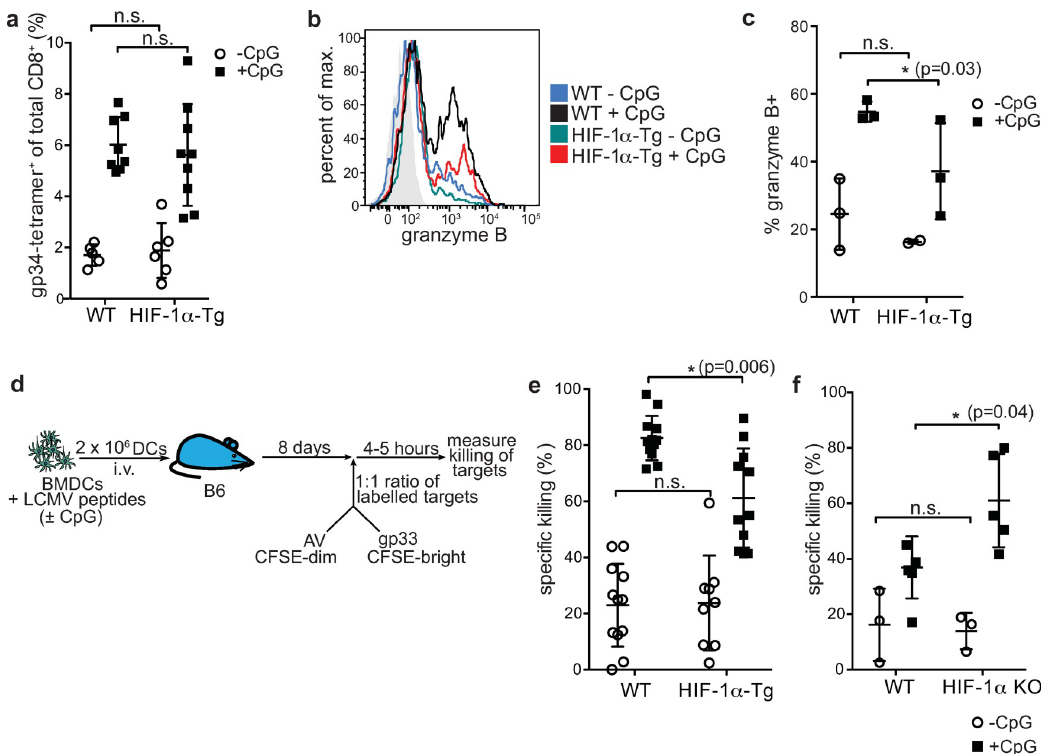
Fig 3. Constitutive expression of HIF-1 α -dPA in BMDCs limits cytotoxic CD8 + T cell responses. ( a ) RIP-gp mice were vaccinated with gp-peptide pulsed, unstimulated or CpG-stimulated, WT or HIF-1 α -Tg BMDCs. Eight days later, blood was collected for tetramer staining of gp-specific CD8 + T cells (gp34-tetramer + ). ( b ) Pancreatic infiltrating lymphocytes (PIL) were isolated from RIP-gp mice 6 days following WT or HIF-1 α -Tg BMDC vaccination and stained for granzyme B. Representative staining for CD8 + PIL is shown in the histogram and ( c ) the percentage of granzyme B + PIL (of CD8 + CD45 + cells) is shown. ( d ) Overview of the CTL assay used to assess antigen-specific killing of targets in vivo . Peptide-pulsed, CpG stimulated or unstimulated, WT or HIF-1 α -Tg BMDCs were infused into na ï ve B6 host animals. Eight days later, fluorescently labeled, peptide- pulsed target cells were given i.v., and spleens of recipient mice were harvested and analyzed by flow cytometry to assess the antigen-specific, direct killing capacity of CTLs in vaccinated mice. CTL data for mice vaccinated with ( e ) WT or HIF-1 α -Tg BMDCs or ( f ) WT or HIF-1 α KO BMDCs, is shown. For ( e ) and ( f ), open circles represent mice given unstimulated BMDCs (-CpG), while shaded squares represent mice given CpG-stimulated BMDCs (+CpG). Data are representative of 2–3 independent experiments, with 2–3 mice per group. For ( a ) and ( e ), data were pooled from three independent experiments. � P � 0.05; n.s.: not significant. Statistical testing was performed with two-way ANOVA and Tukey’s